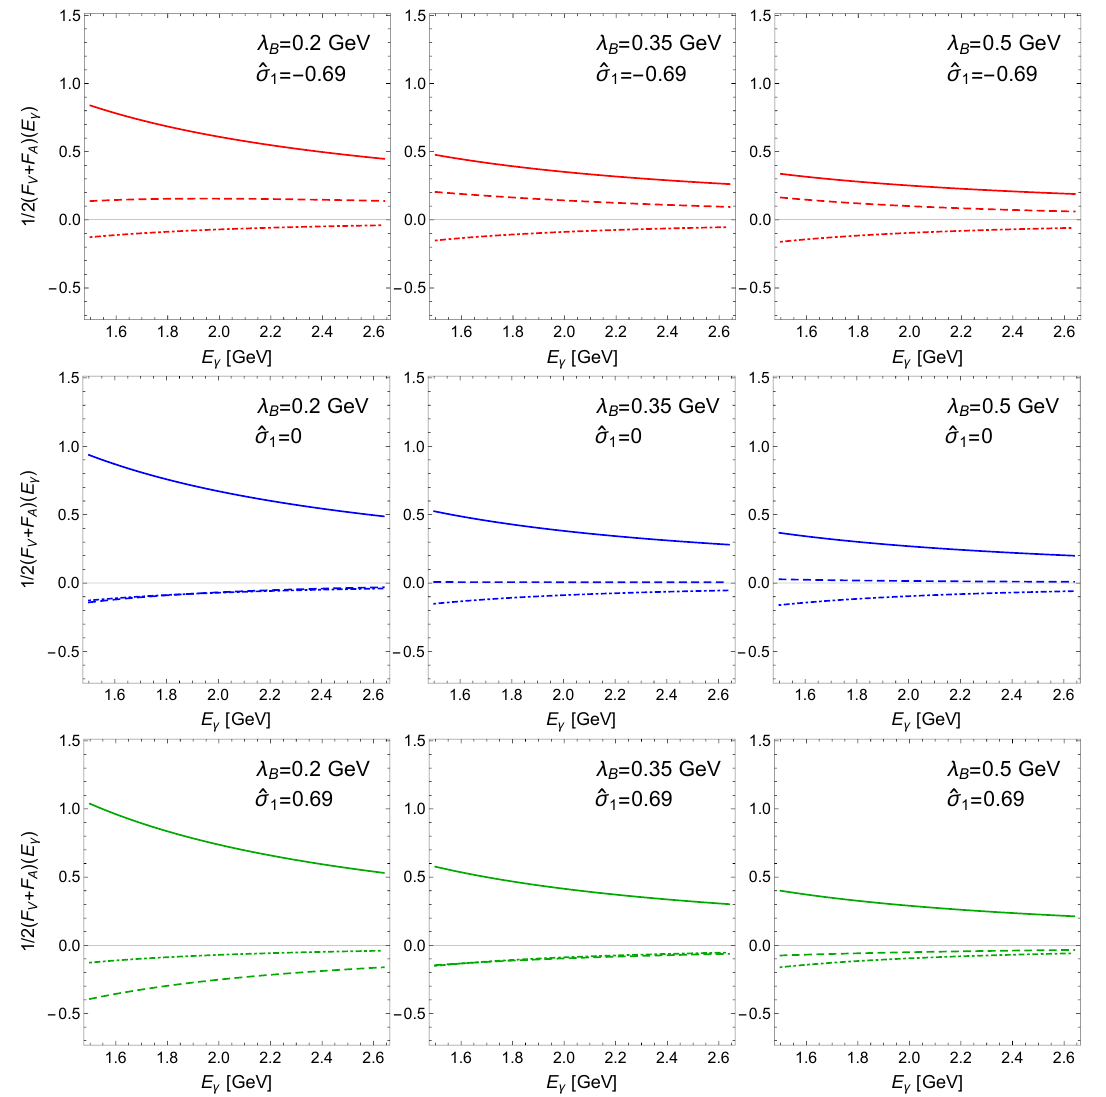
Figure 5 . Perturbative (solid curves), soft (dashed curves) and higher-twist (dash-dotted curves) contributions to the form factor (1 = 2)( F V + F A ) as functions of photon energy E (cid:13) for di(cid:11)erent choices of the parameters (cid:21) B and (cid:27) 1 . The colour coding corresponds to (cid:12)gure 3.